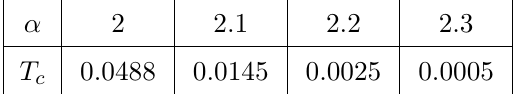
Table 1. Value of critical temperature T c as a function of (cid:11) for given F ( ) = (cid:11) and (cid:12)xed (cid:14)(cid:22) =